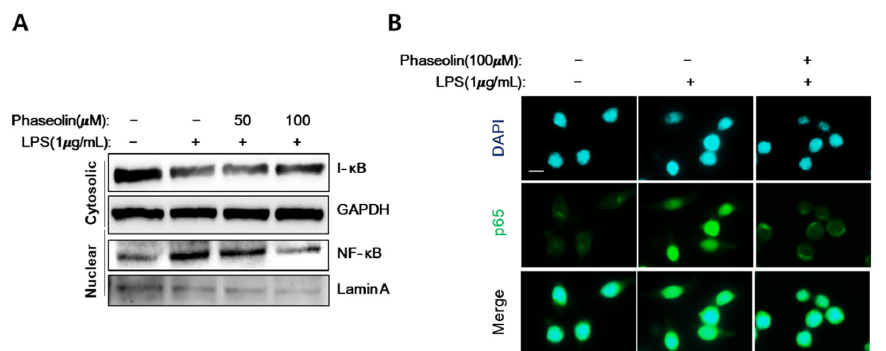
Figure 7. Effects of phaseolin on nuclear NF- κ B translocation and inhibitor kappa B (I- κ B) degradation. RAW 264.7 cells were treated with LPS (1 μ g/mL) alone or LPS + phaseolin (50 or 100 μ M) for 24 h and then the expression levels of nuclear NF- κ B and cytoplasmic I- κ B were assessed using Western blotting ( A ) and immunofluorescence staining of NF- κ B ( B , green). Nuclei were stained with 1 μ g/mL DAPI (blue). A scale bar indicates 10 μ m.